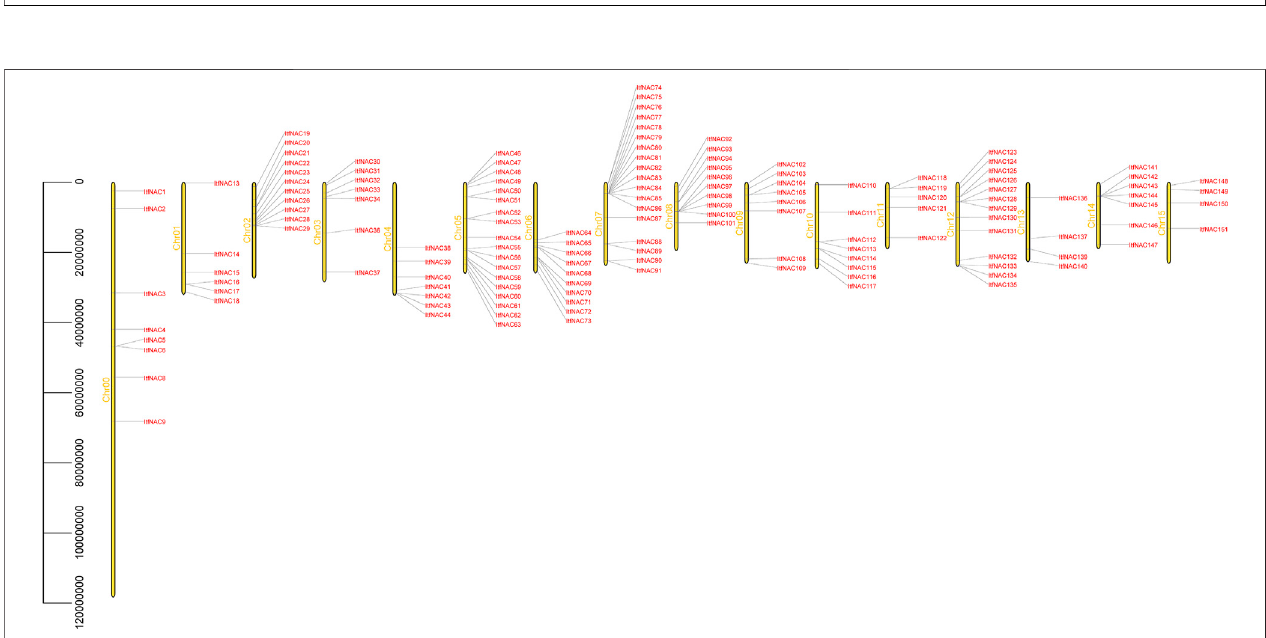
FIGURE 3 | Chromosomal location of ItfNAC genes. Yellow bars on the left side represent chromosomes, and gene ID on the right side represents its location mapped on the chromosome. 144 ItfNAC genes were unevenly distributed across 16 Ipomoea tri fi da chromosomes.